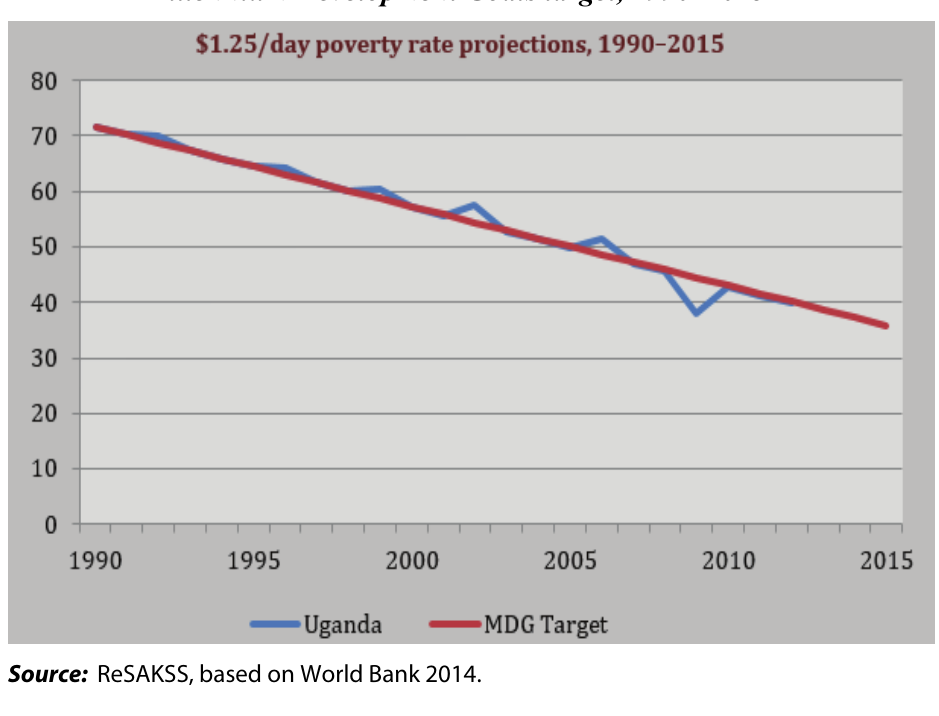
Figure 2: Uganda $1.25/day poverty rate projections compared to Millennium Development Goals target, 1990–2015